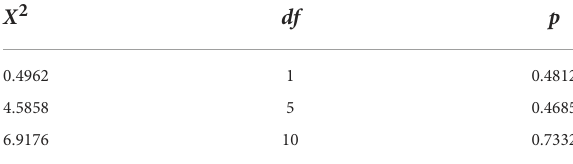
TABLE 2 Box L Jung analysis output for insignificant